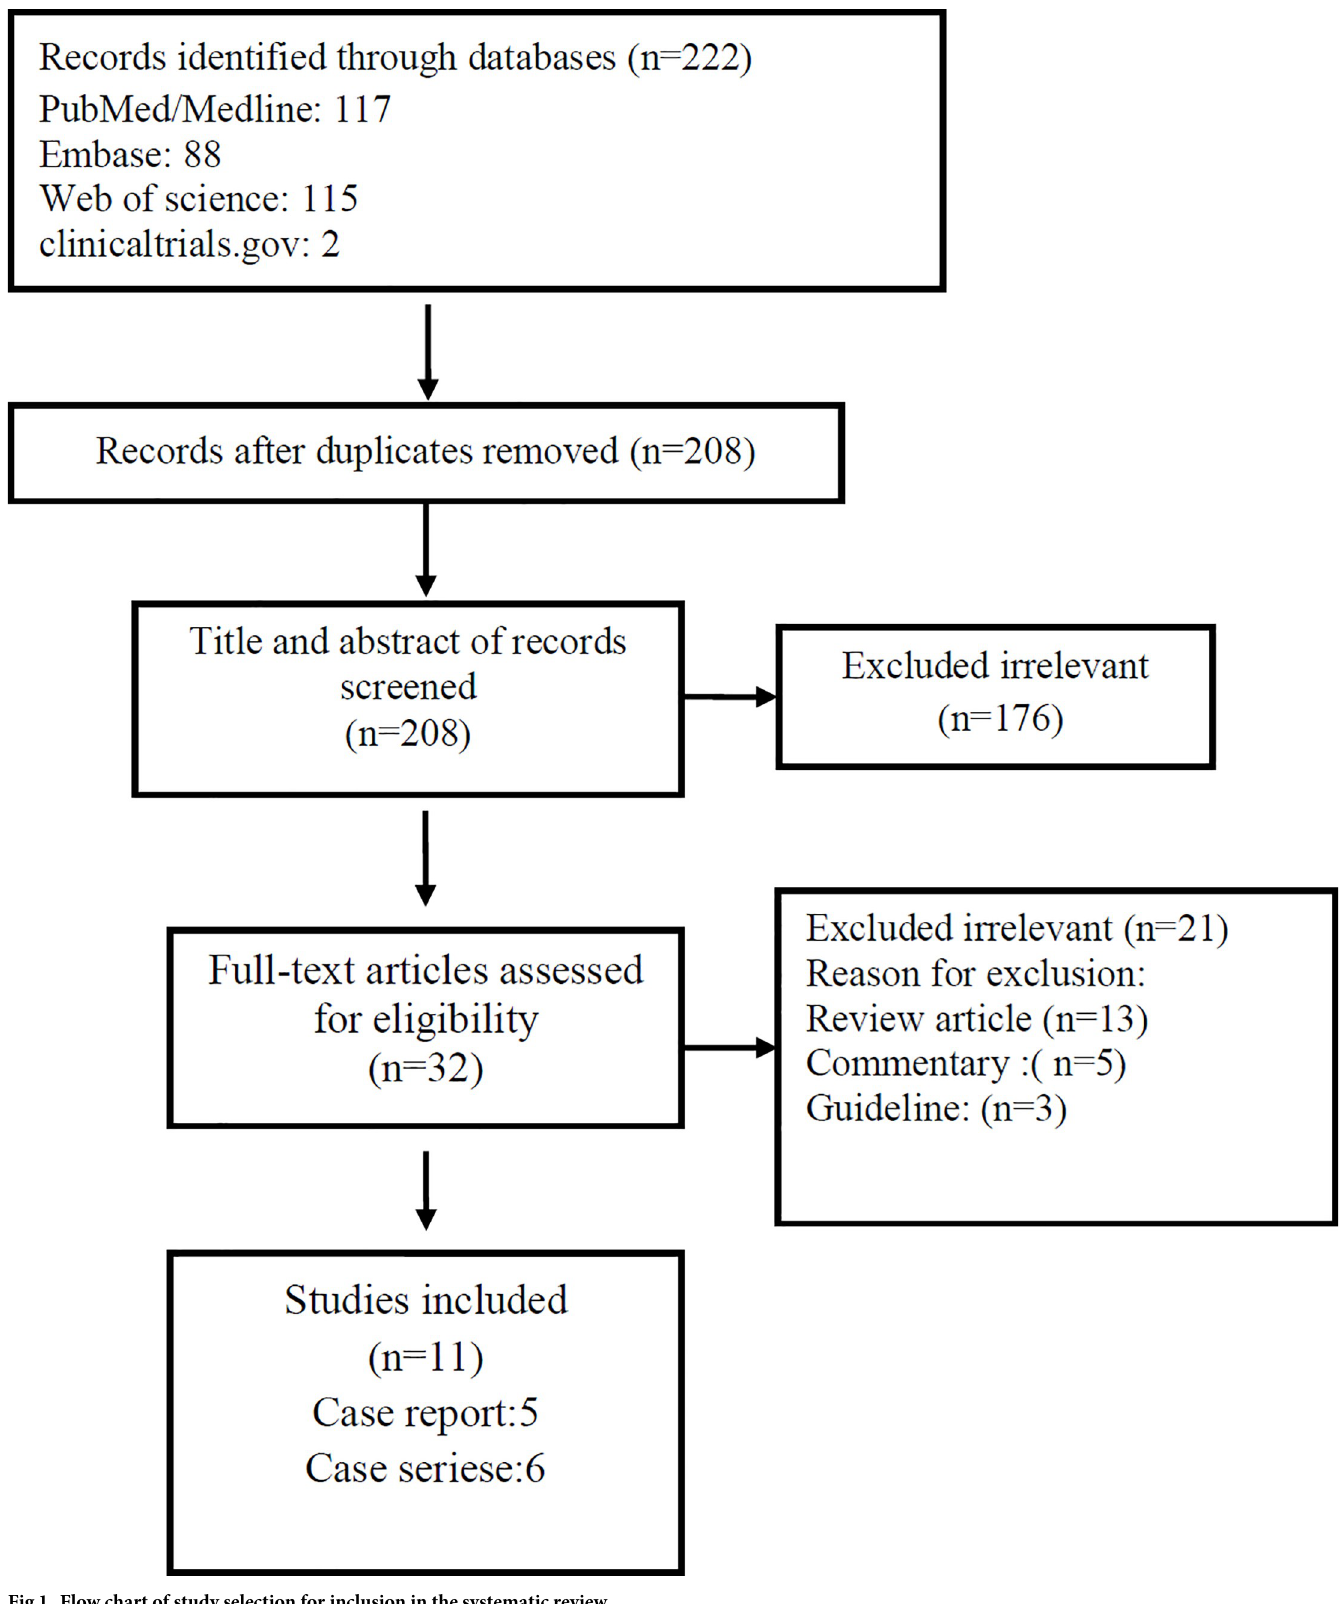
Fig 1. Flow chart of study selection for inclusion in the systematic review.